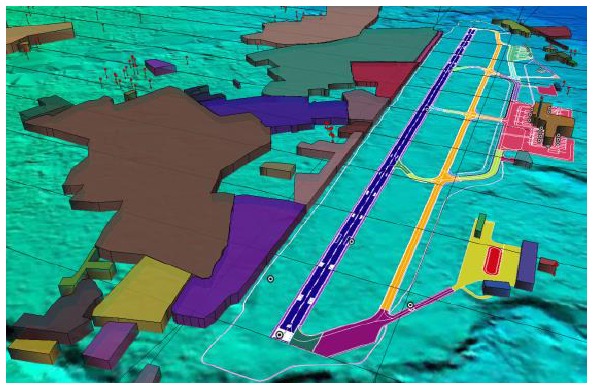
Figure 7: Three-dimensional airport map